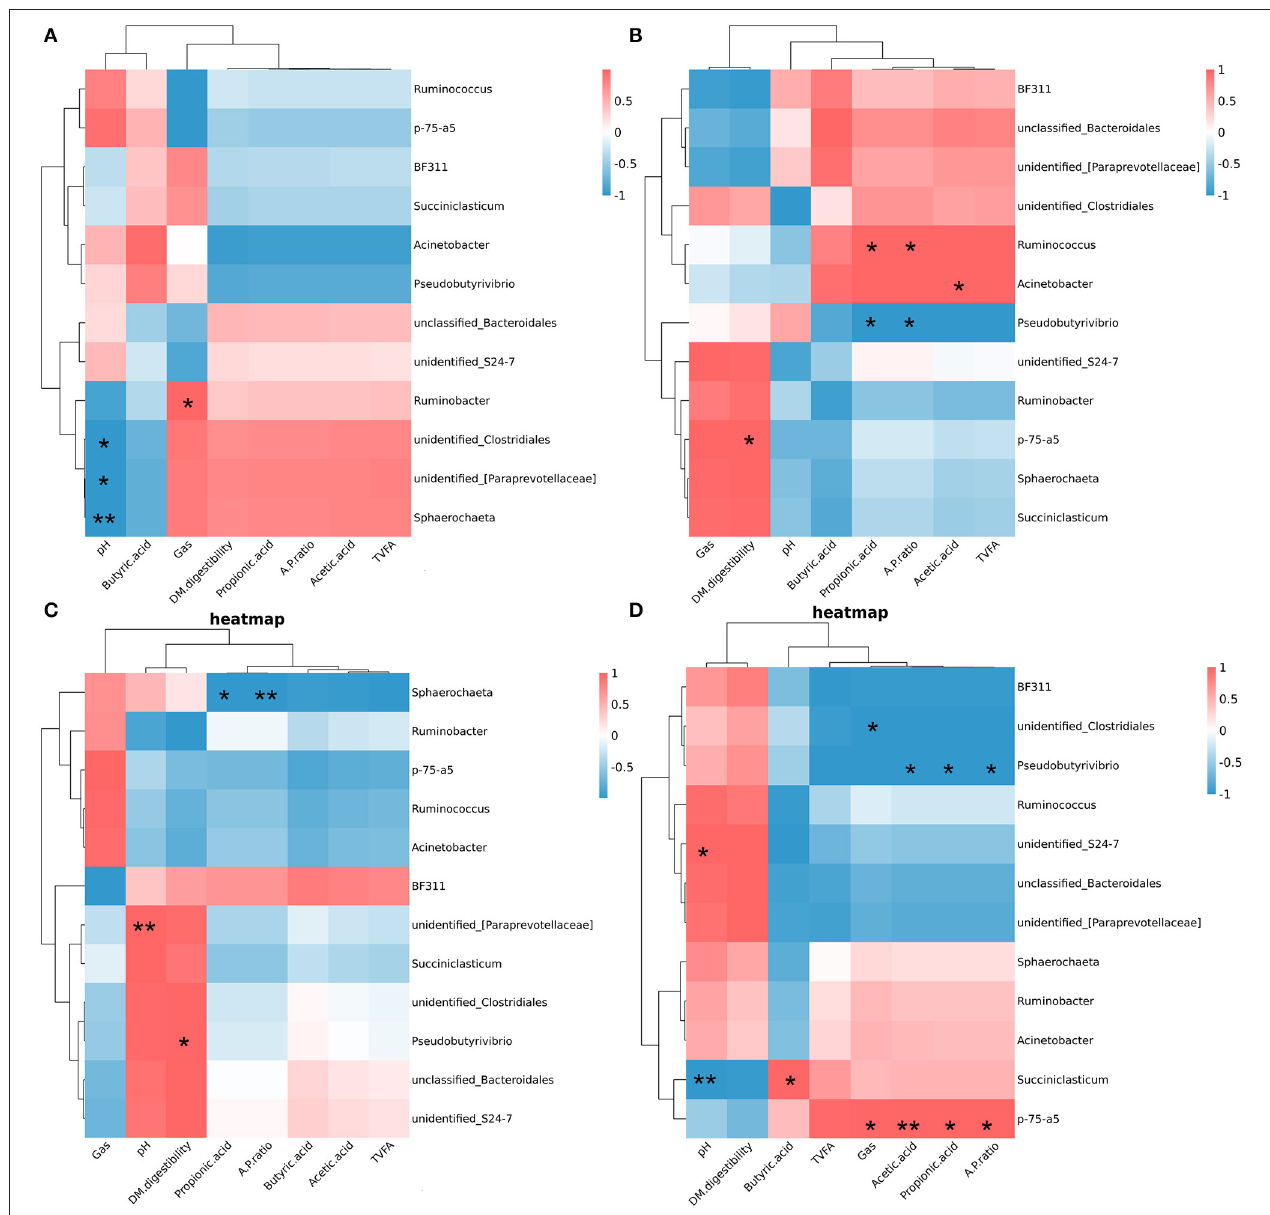
FIGURE 9 | Spearman correlations between specific bacterial genera, rumen fermentation parameters, and Dry matter digestibility. (A) Spearman correlations within diet of diet of low starch and low sugar. (B) Spearman correlations within diet of diet of low starch and high sugar. (C) Spearman correlations within diet of diet of high starch and low sugar. (D) Spearman correlations within diet of diet of high starch and high sugar. * P < 0.05; ** p <